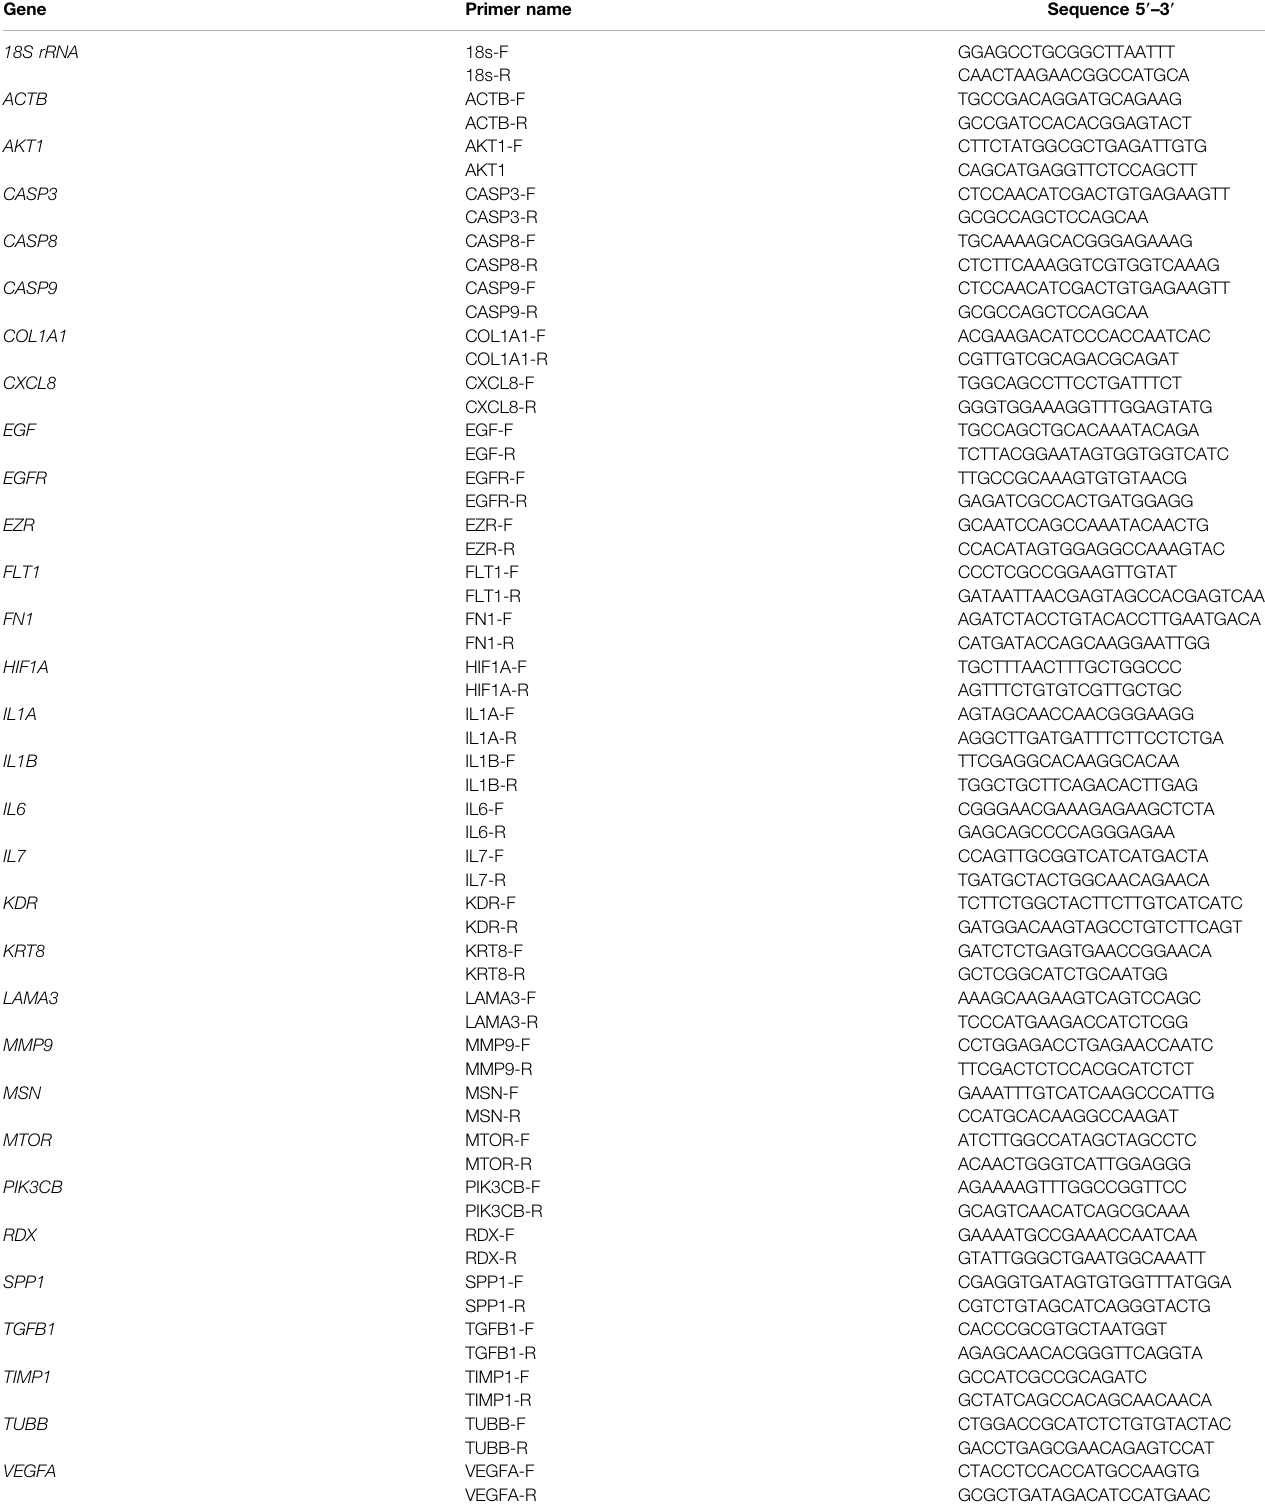
TABLE 1 | Primers used for qPCR analyses.